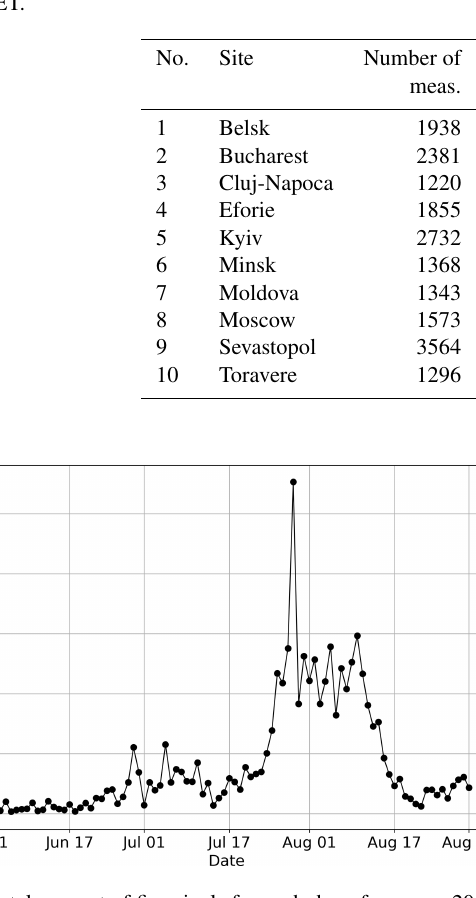
Figure 3. Total amount of fire pixels for each day of summer 2010 according to MODIS Aqua and Terra data over the area shown in Fig. 1 (40–65 ◦ N and 10–60 ◦